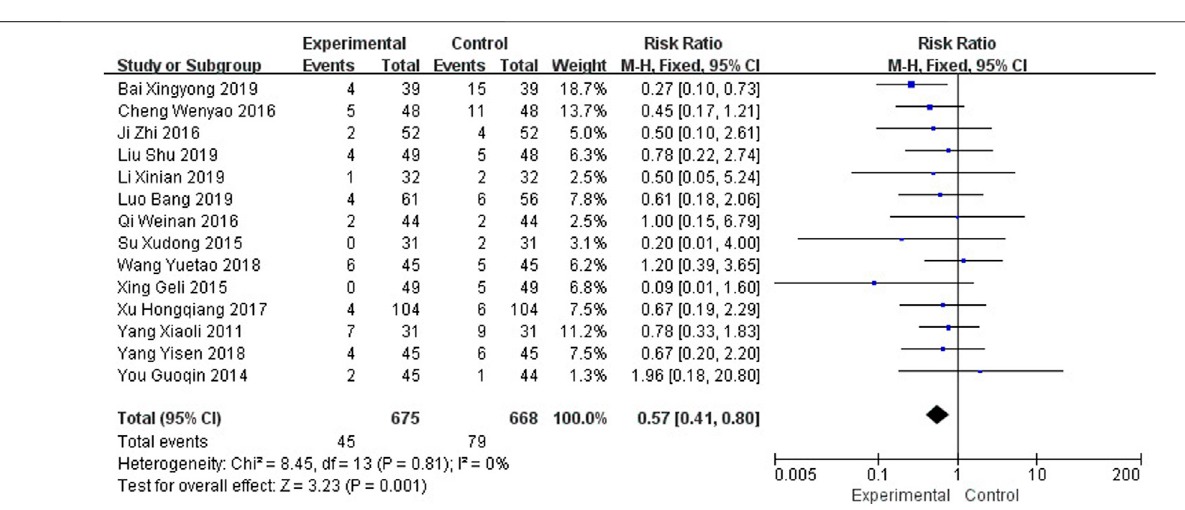
Frontiers in Pharmacology |